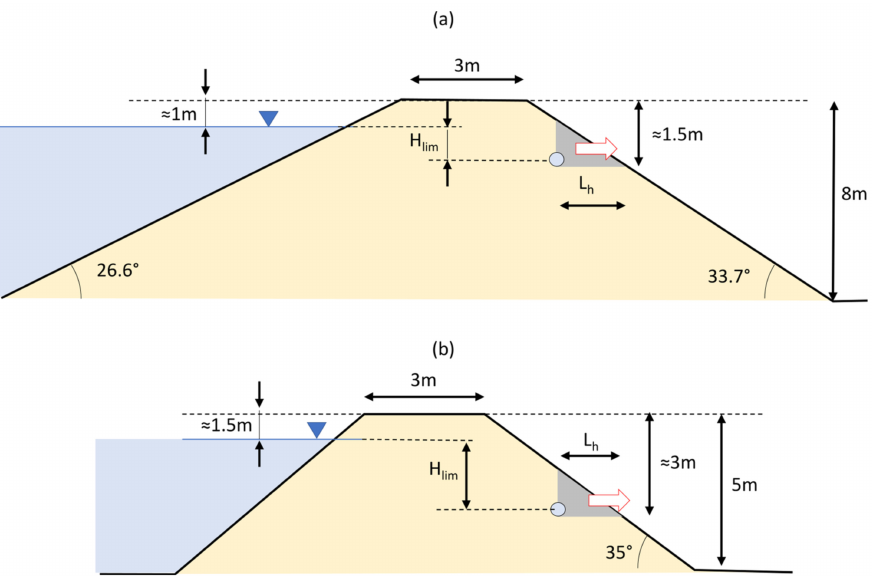
Figure 10. Schematic view of the proposed mechanism for ( a ) Santa Clara Dam and ( b ) Panaro